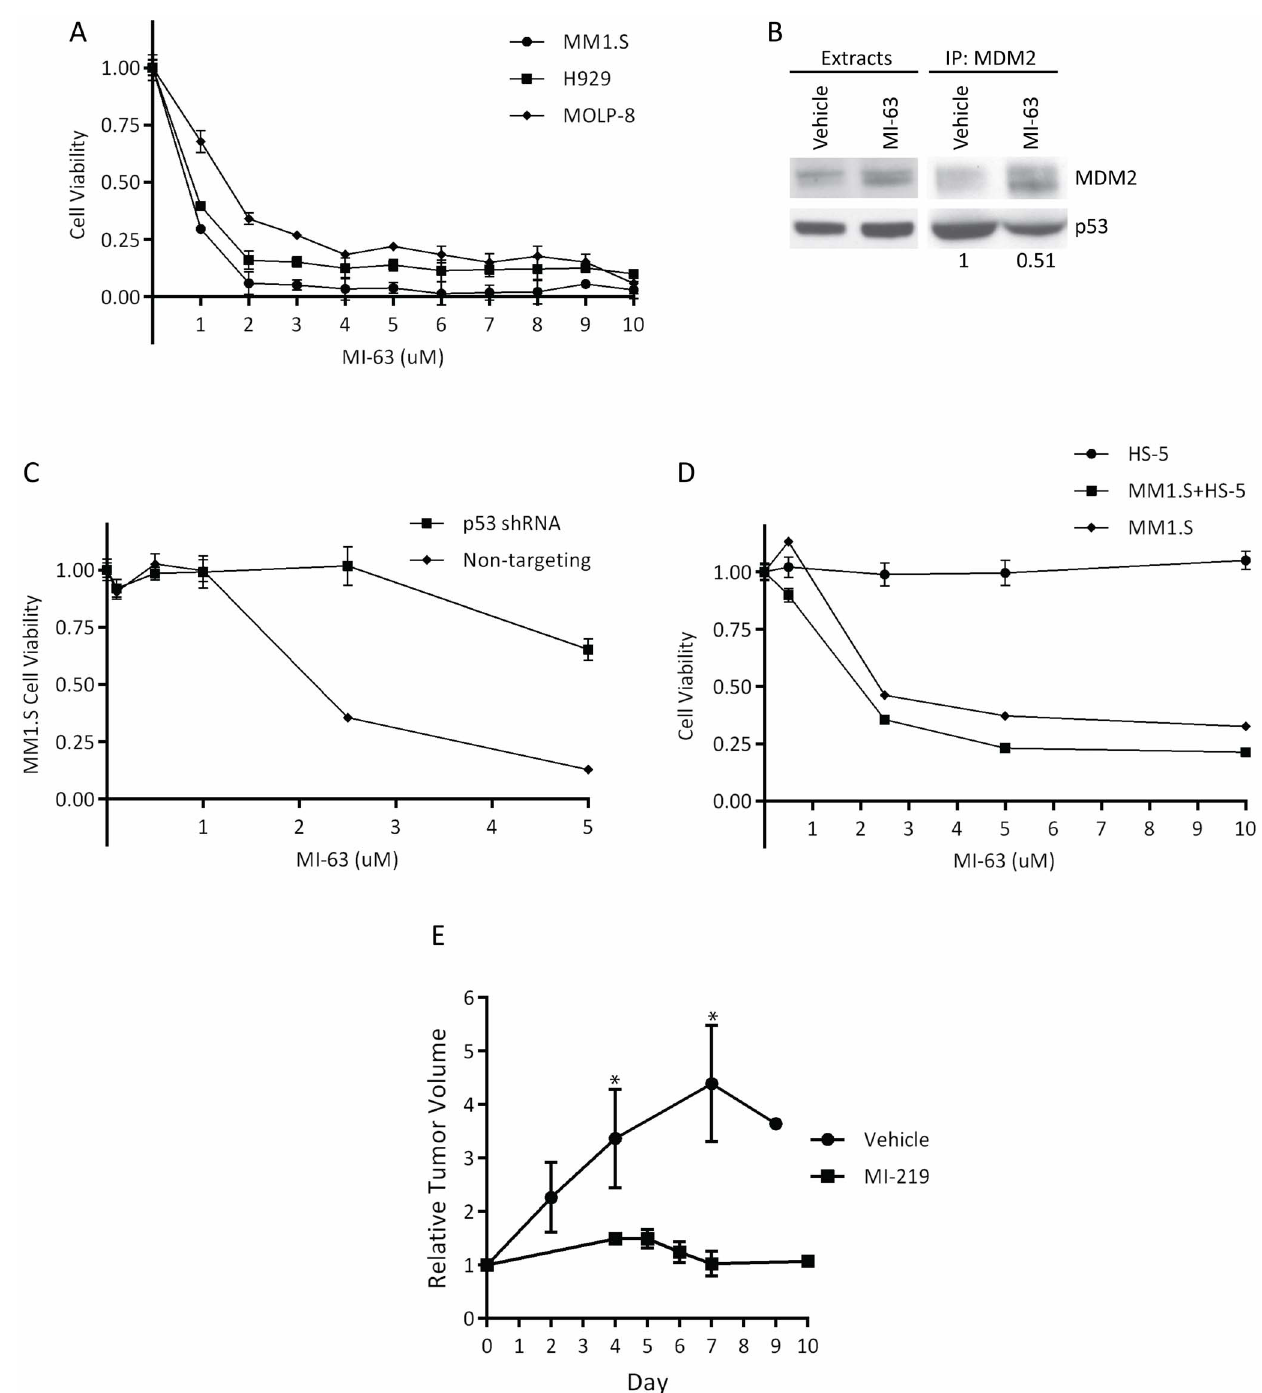
Figure 1. MI-63 is cytotoxic to wild-type p53 myeloma cells. A. Cell viability assays were performed in wild-type p53 myeloma cell lines exposed to the indicated concentrations of MI-63 for 48 hours using a tetrazolium reagent. Error bars represent standard errors of the mean from three or more replicates, and all experiments in this and later figures were repeated three times, with one representative figure shown. B. Whole cell extracts were prepared from MM1.S cells treated with vehicle or MI-63, and then subjected to immunoprecipitation with an antibody to MDM2. The precipitates were then probed by Western blotting using specific antibodies to MDM2 or p53, and densitometry was performed using Image J software. C. MM1.S cells stably infected with a Lentiviral vector expressing either a control, non-targeted shRNA or an shRNA directed at p53 were exposed to MI-63 as above, and viability was measured using the WST-1 reagent. D. Human stromal HS-5 cells or MM1.S myeloma cells were propagated in culture either alone, or co-cultured at a ratio of 20:1, and viability was measured in the presence of MI-63. E. A murine xenograft myeloma model was developed in NOD/SCID mice, and when tumor volume reached 100 mm 3 , mice were treated intraperitoneally with 100 mg/kg MI-219 or vehicle, and tumor volume was monitored three times a week. Vehicle-treated mice experienced a substantial increase in the tumor burden, while MI-219 induced a significant tumor growth delay, (* p , 0.05).